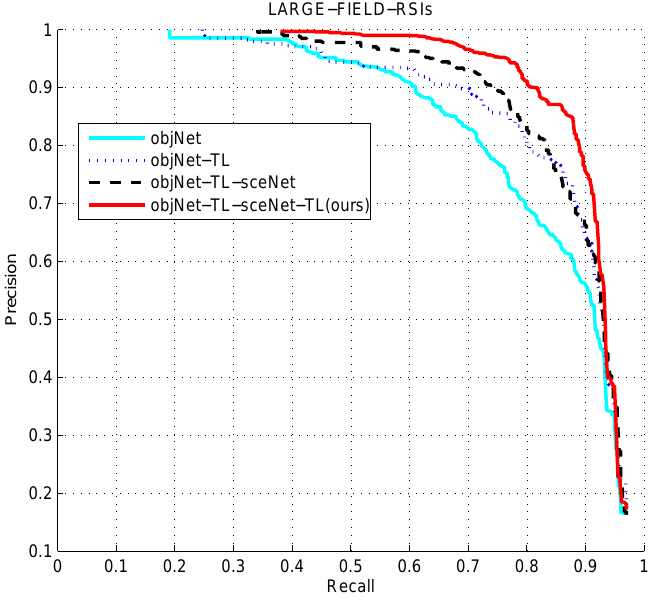
Figure 20. The performance comparison of four experiments on the LARGE-FIELD-RSIs dataset.